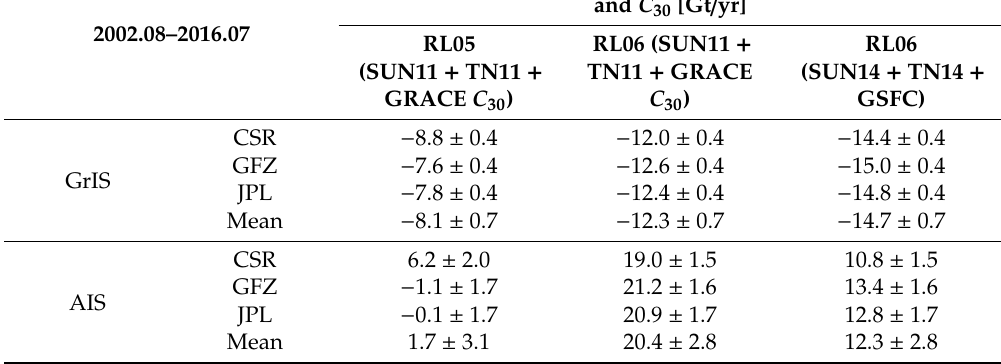
Table 6. The trends of mass change time series caused by the combination of degree one terms, SLR-based C 20 and C 30 estimates corresponding to GRACE RL05 and RL06 data over the GrIS and the AIS during the period from August 2002 to July